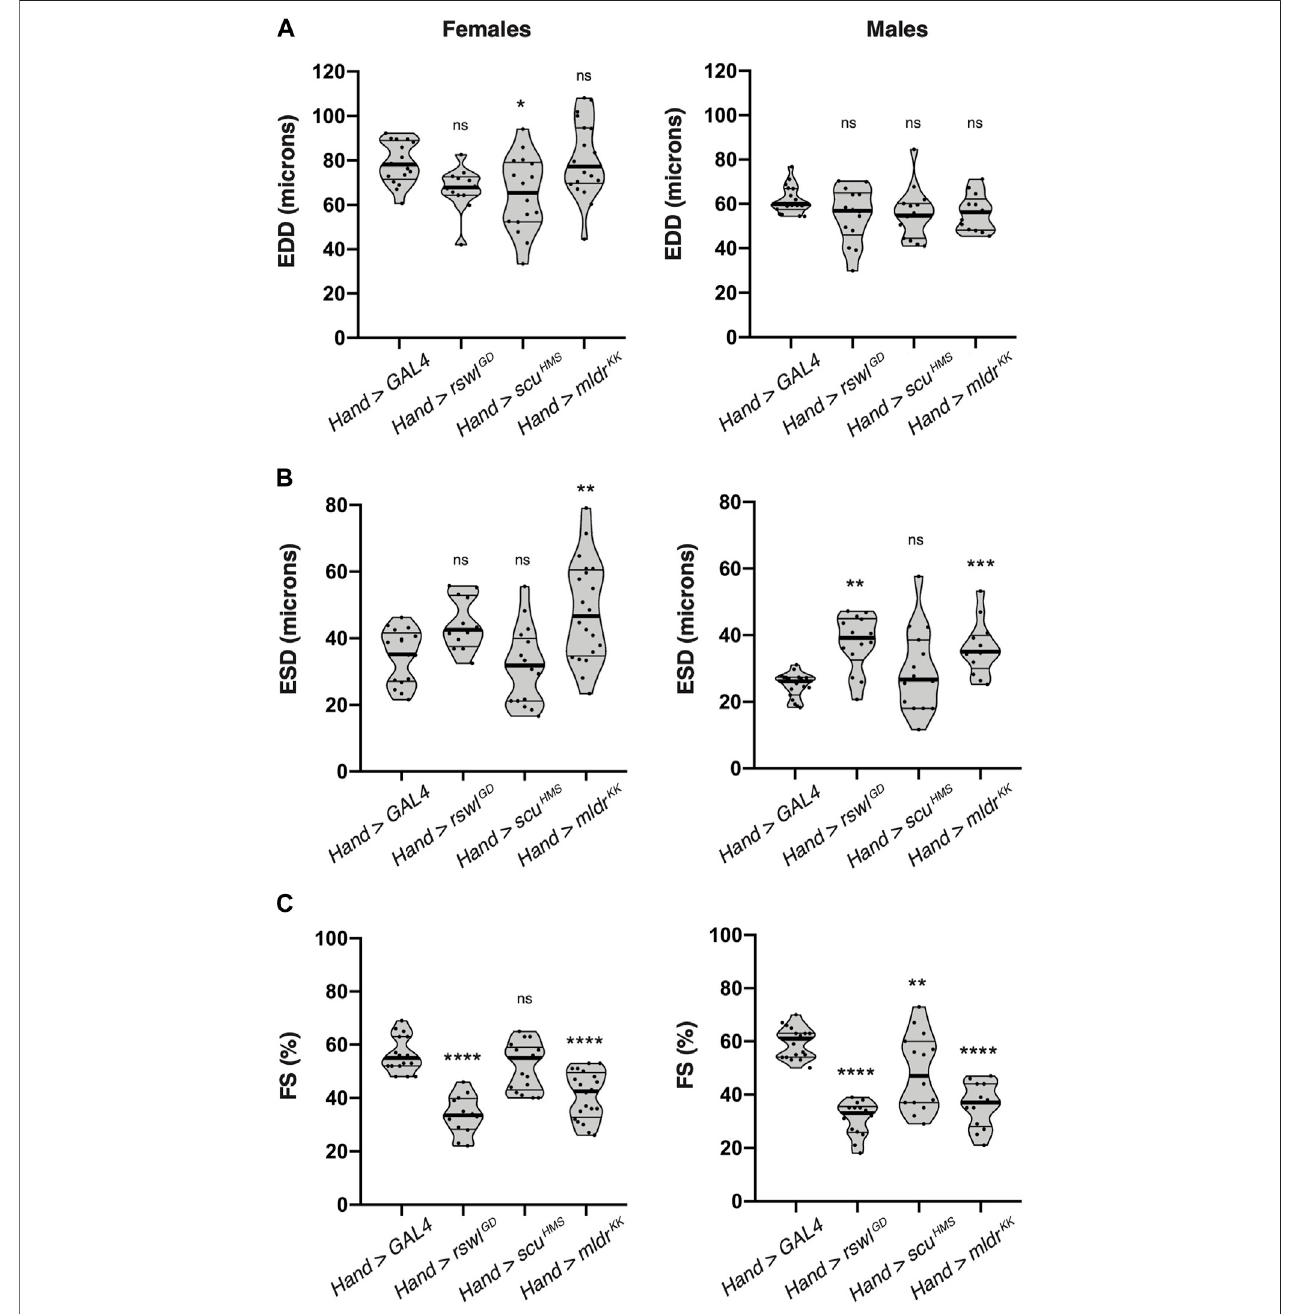
FIGURE6| ReductionofmtRNAsePsubunitsintheadultheartsigni fi cantlyreducesheartcontractility.Intravitalimagingkymographicheartmeasurementsfor (A) end-diastolic dimension (EDD), (B) end-systolic dimension (ESD), and (C) percent fractional shortening (FS) from two-day-old female and male adult hearts expressing GAL4 (control), rswl GD , scu HMS , and mldr KK RNAi using Hand GAL4 at 29 ° C. The points on each violin plot represent an average of fi ve measurements from one fl y and themedian and quartiles arerepresented bythehorizontalsolidlines.Statisticalsigni fi cancewascalculated withGraphPadPrism using Ordinary one-wayANOVA and Tukey ’ s multiple comparison test. p valuescompare tocontrol ( GAL4 )to each experimental RNAi. *= p < 0.05, ** = p < 0.01, ***= p < 0.001,**** = p < 0.0001.ns = not signi fi cant. The graphs were plotted using GraphPad Prism.